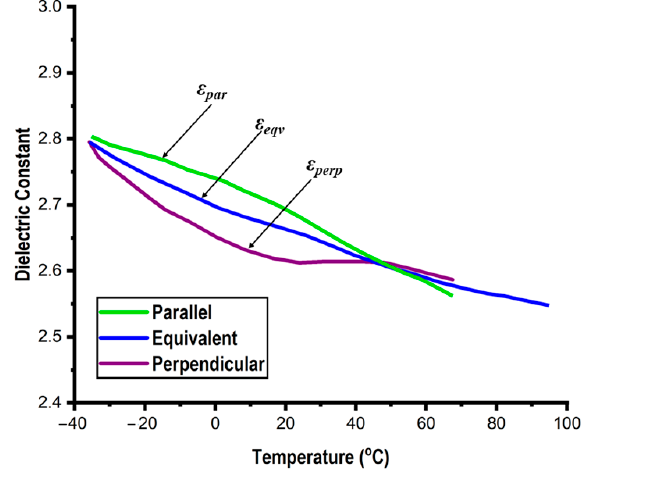
Table 5. Measured values of dielectric parameters of PDMS at di ff erent temperatures (parallel val- ues—12.5 GHz; perpendicular values—7.5 GHz; equivalent values—10 GHz).